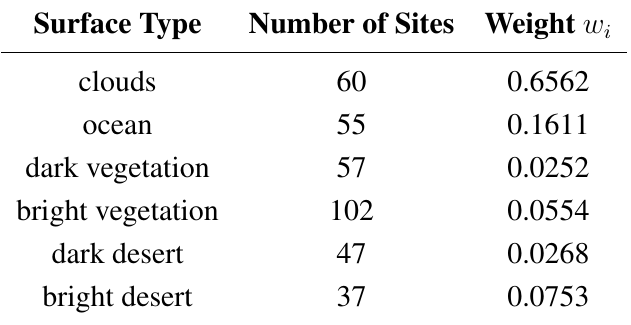
Table 3. For each surface type, the number of sites used in each time series is given together with the weight values used in the cost function of Equation